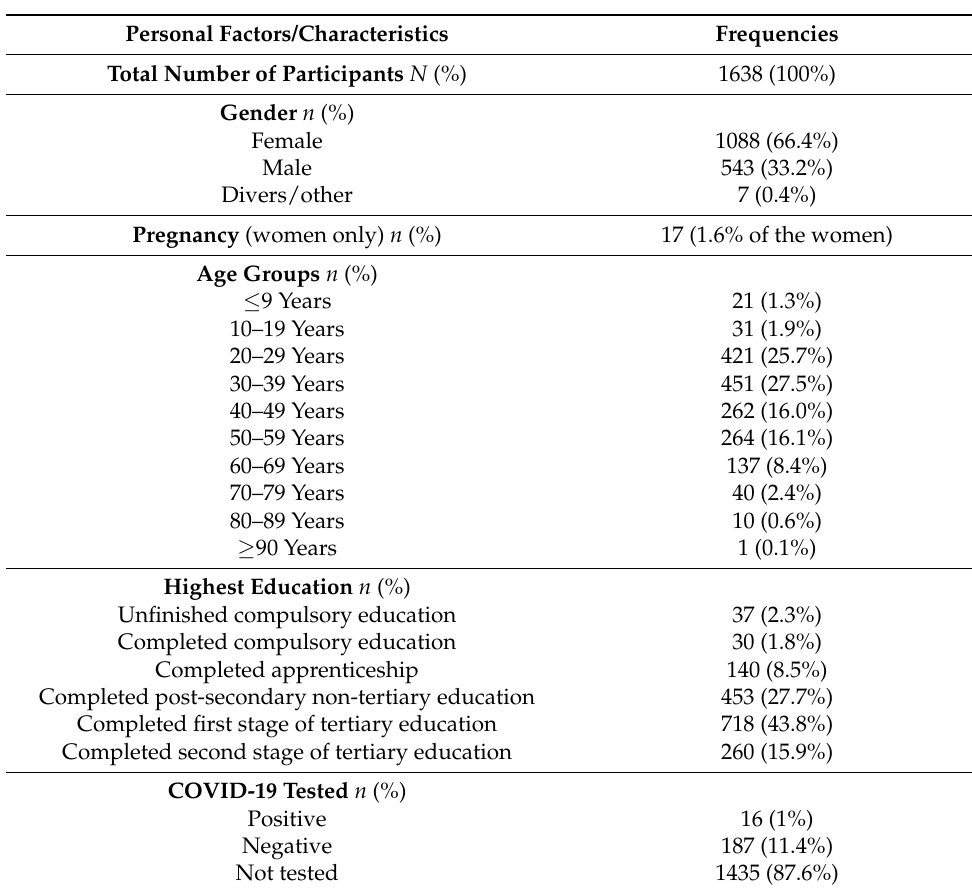
Table 1. Participant